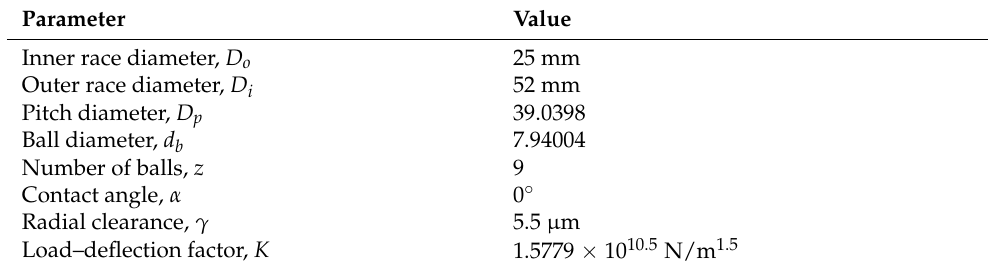
Table 1. Geometrical specifications of 6205-2RS JEM SKF deep-groove bearing [60,61].